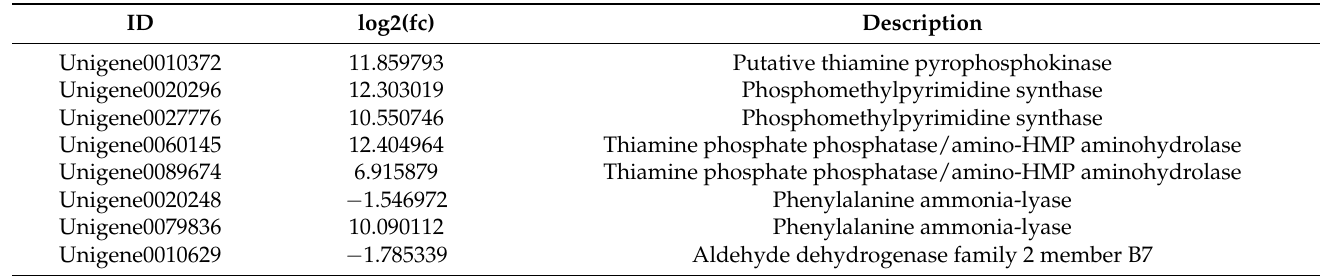
Table 5. Screening of differential enzyme